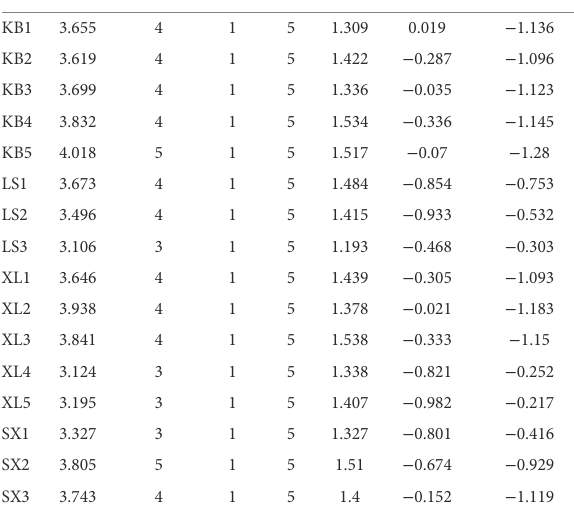
TABLE 8 Study 2: Descriptive statistical analysis of each variable (historical